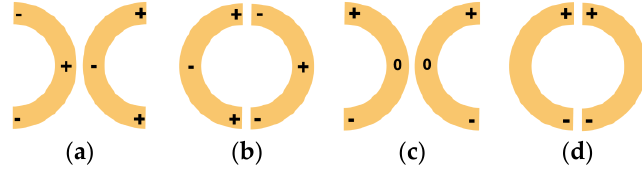
Figure 9. Schematics of the oscillation of free electrons of gold curvilinear nanorod dimers with narrow gap widths. The directions of linearly polarized light are x -direction for ( a ) and ( b ), and y -direction for ( c ) and ( d ).